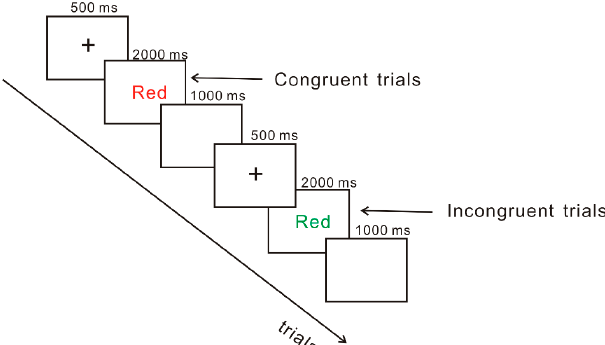
Figure 1. Depiction of a congruent and an incongruent trial in the color–word Stroop task.